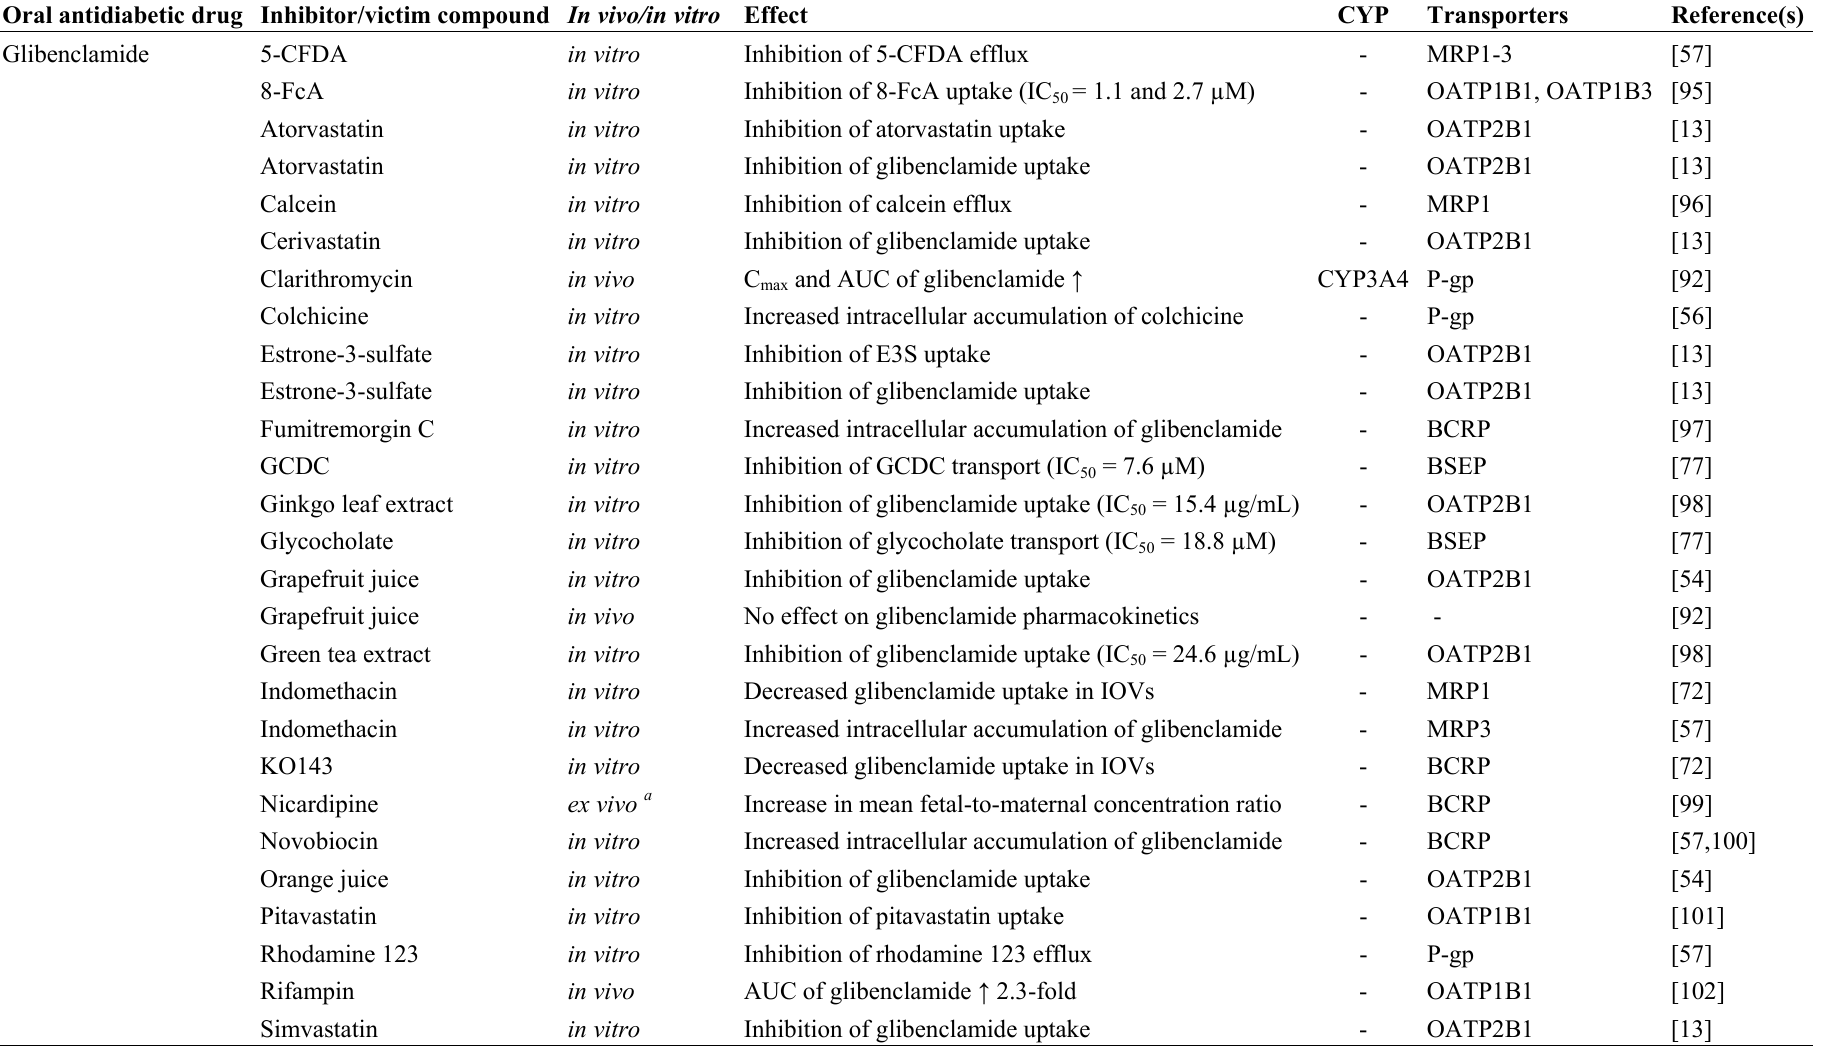
Table 2. Selected human solute carriers (SLC) and ATP-binding cassette (ABC) transporters involved in interactions with oral antidiabetic drugs. Oral antidiabetic drug Inhibitor/victim compound In vivo/in vitro